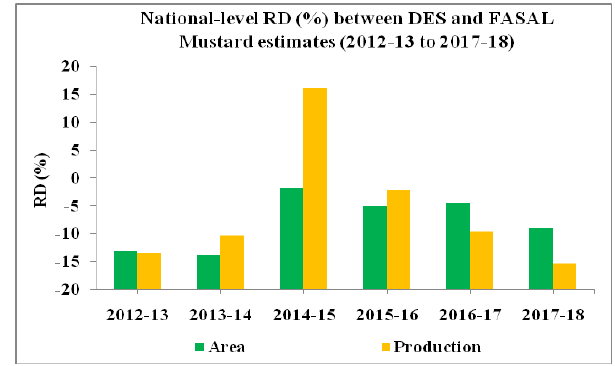
Figure 10: National-level comparison between DES and